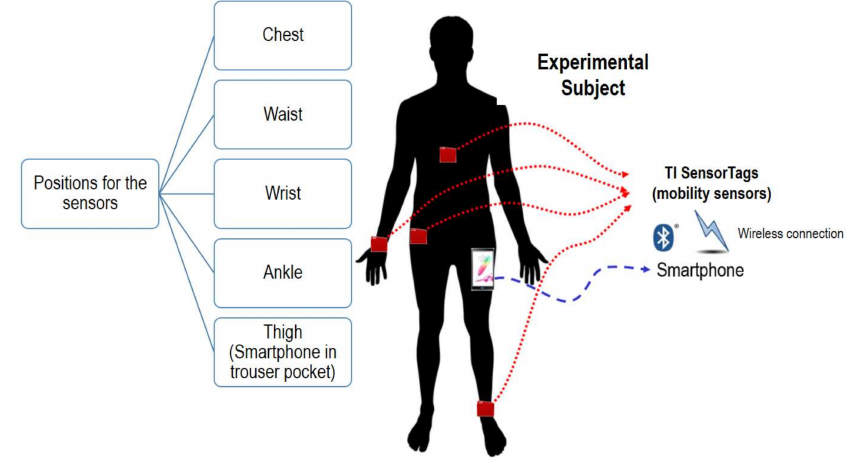
Figure 1. Basic architecture of the